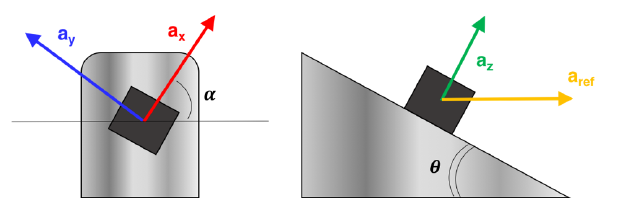
Figure 1. Inclined clamp –